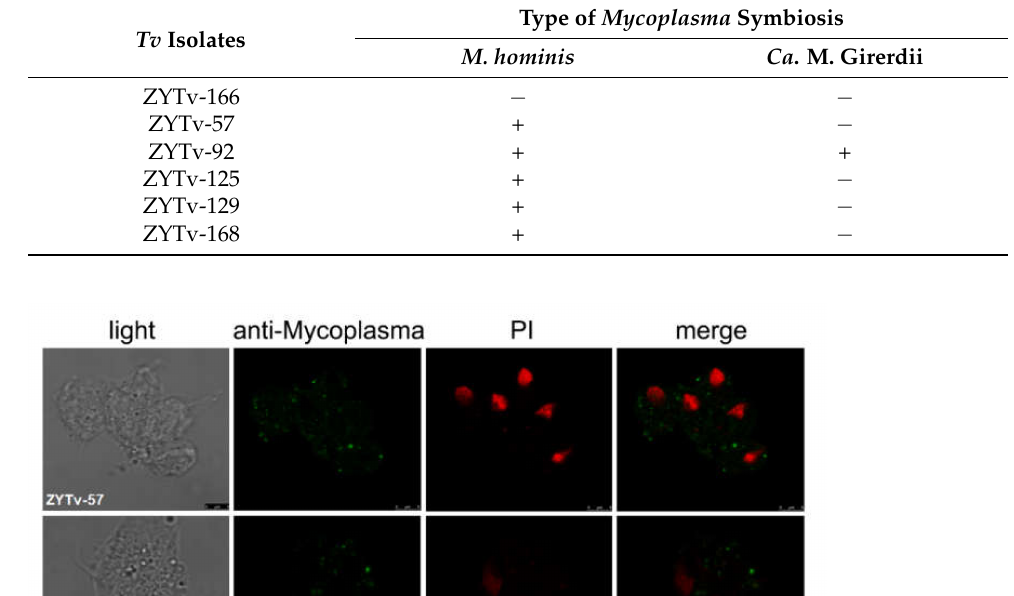
Table 4. Mycoplasma -symbiotic (+) and Mycoplasma -free ( − ) in Tv isolates.